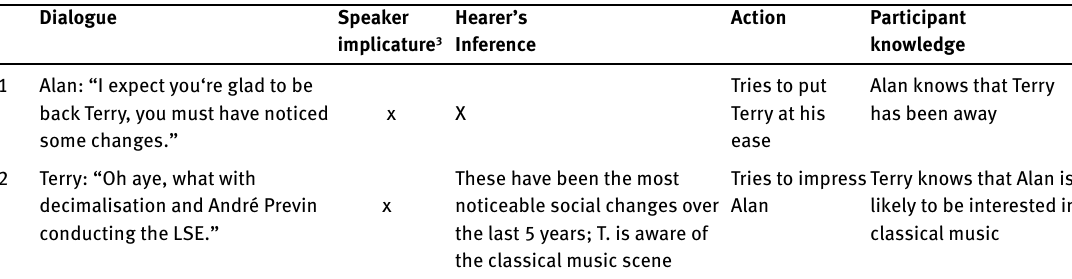
Table 1: ‘Guess who’s coming to dinner’, extract